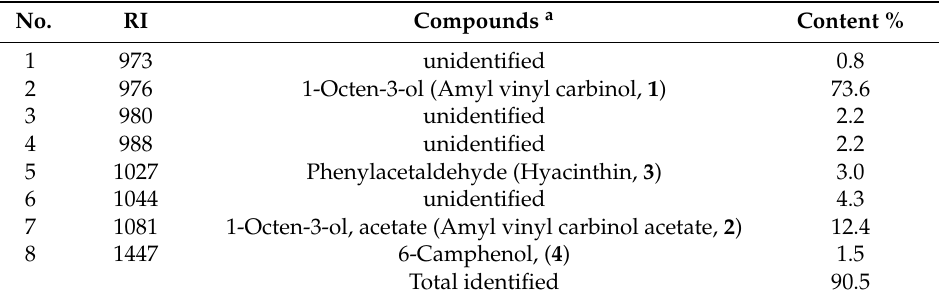
Table 1. Chemical composition of volatile oil of fresh fruiting bodies of G. pfeifferi